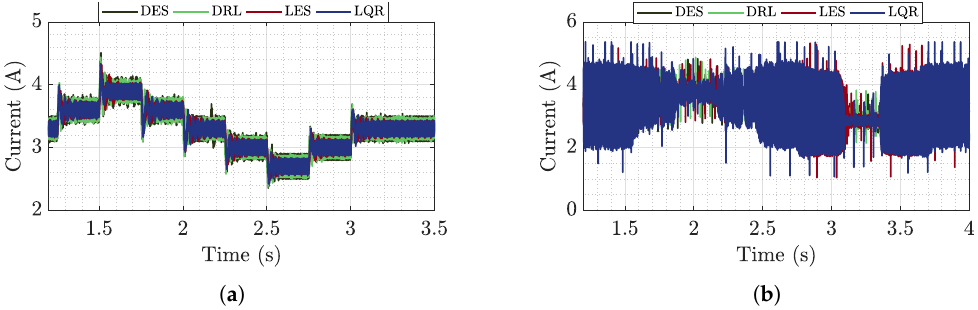
Figure 25. Current in the microgrid buck-boost feeder inductor during the ( a ) simulation and ( b )